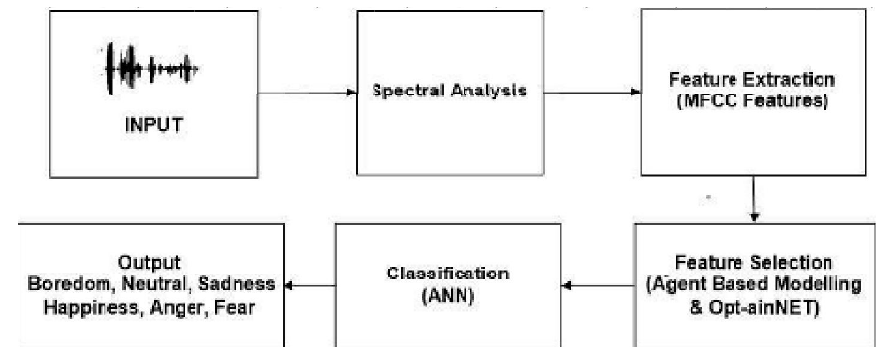
FIG. 1. SCHEMATIC REPRESENTATION OF ER